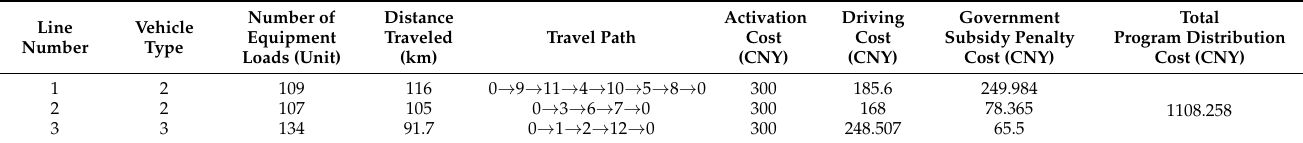
Table 12. Calculated results considering the demand urgency.